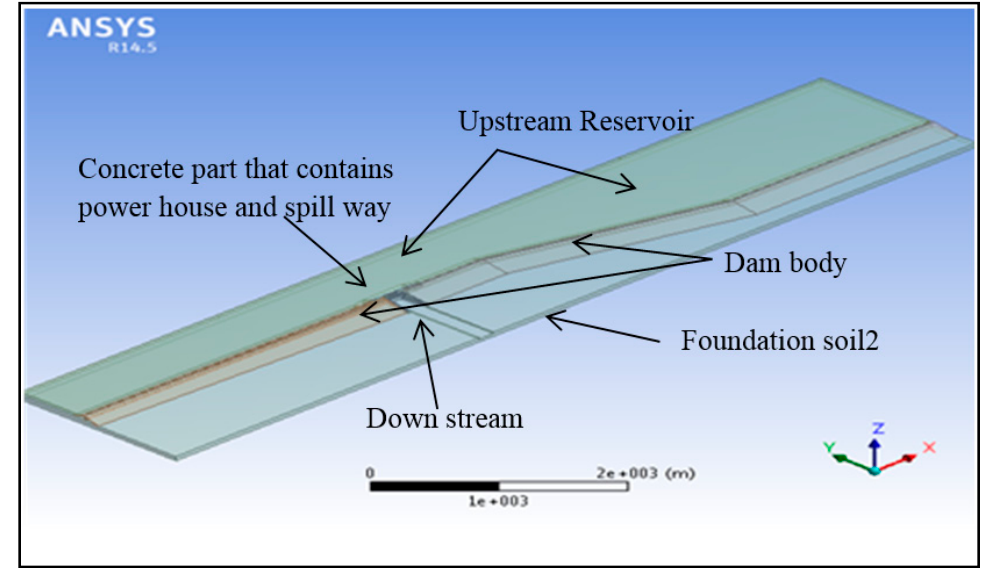
Figure 3. The dam–reservoir–foundation system of Haditha dam.